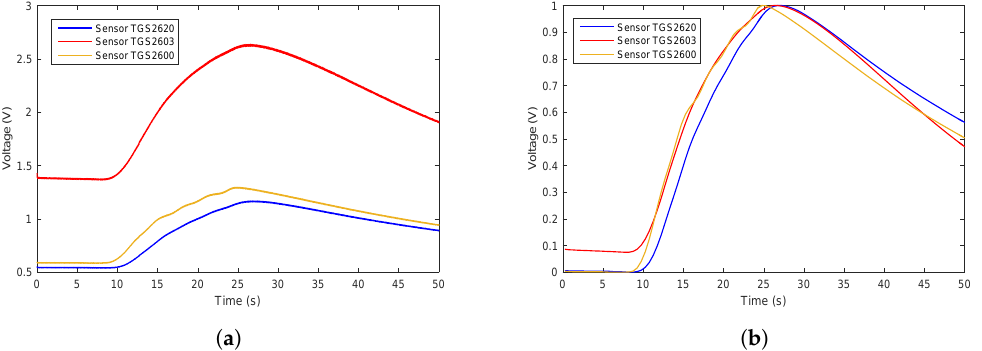
Figure 9. Time series of smoking gases raw data and the data after preprocessing. ( a ) Shows the representative example of the time series of the original response curves of the sensor array for gases from burning cigarettes. ( b ) Shows the results after